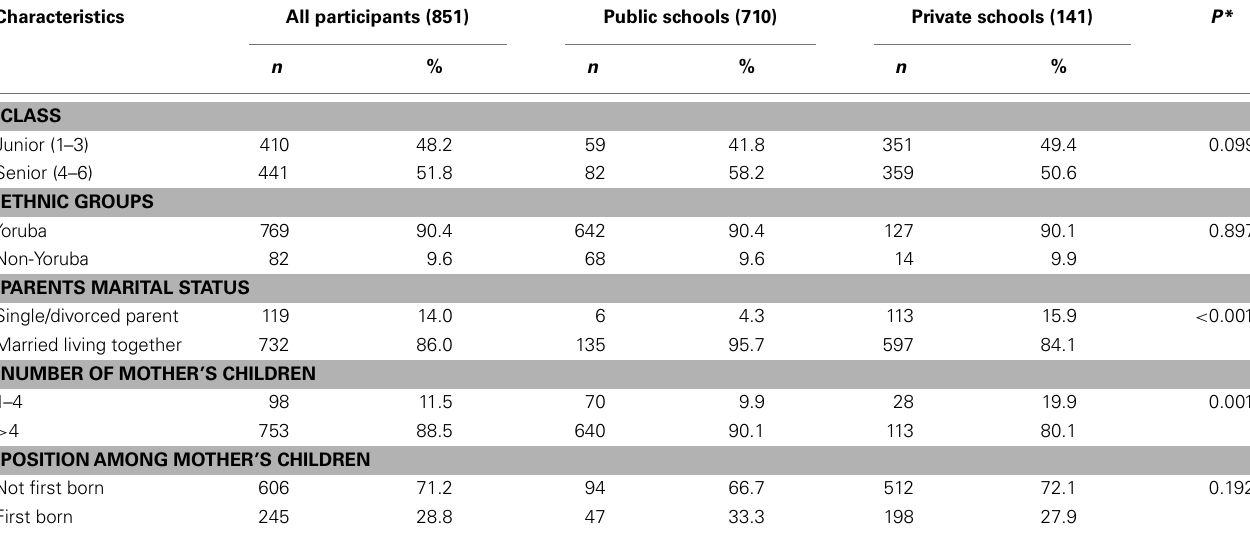
Table 1 | Demographic characteristics of respondents from in private and public schools